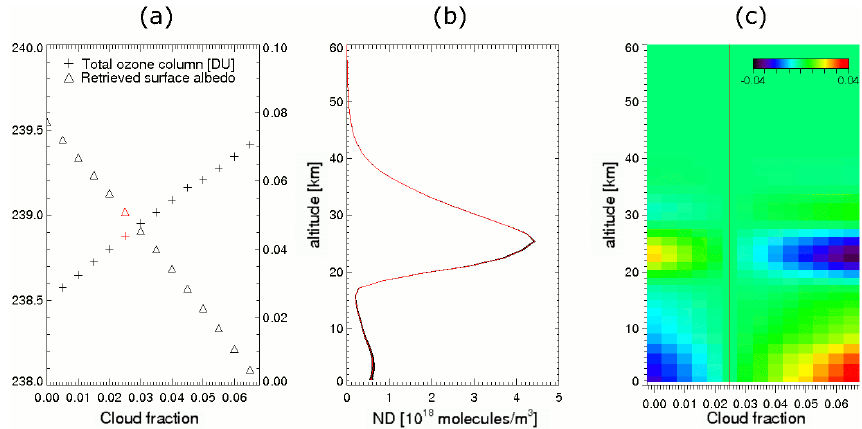
Fig. 6. (a) Dependence of retrieved surface albedo and total ozone column on the cloud fraction. In red, the retrieval corresponding to a surface albedo of 0.05, which is taken as a reference. (b) All retrieved ozone profiles. Small differences occur mainly in the lower part of the ozone bulk and in the troposphere. (c) shows the absolute deviation of number densities in 10 18 molecules/m 3 for each atmospheric layer with respect to the reference profile at f c = 0 .